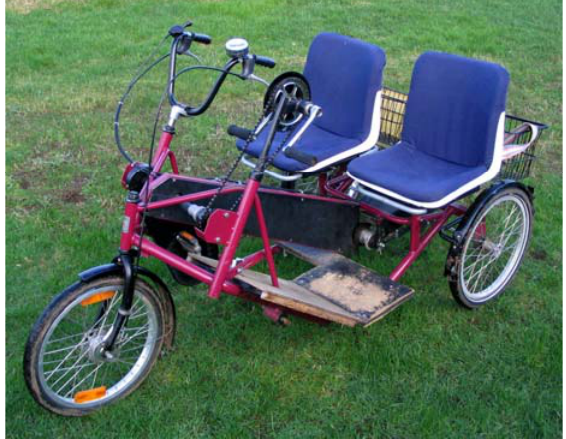
PICTURE 29. Side-by-side